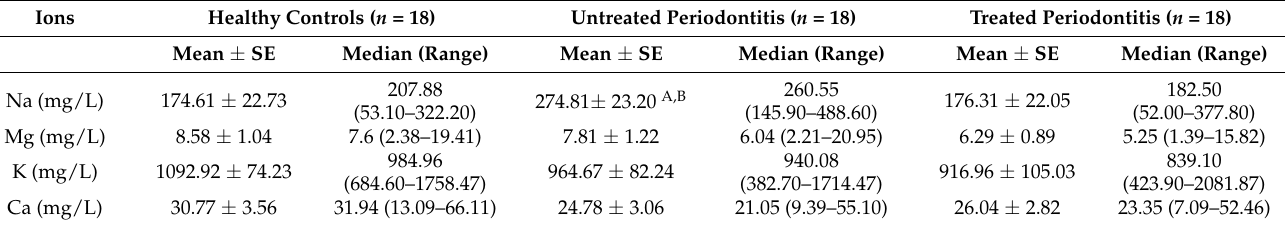
Table 3. Distribution of chemical elements in